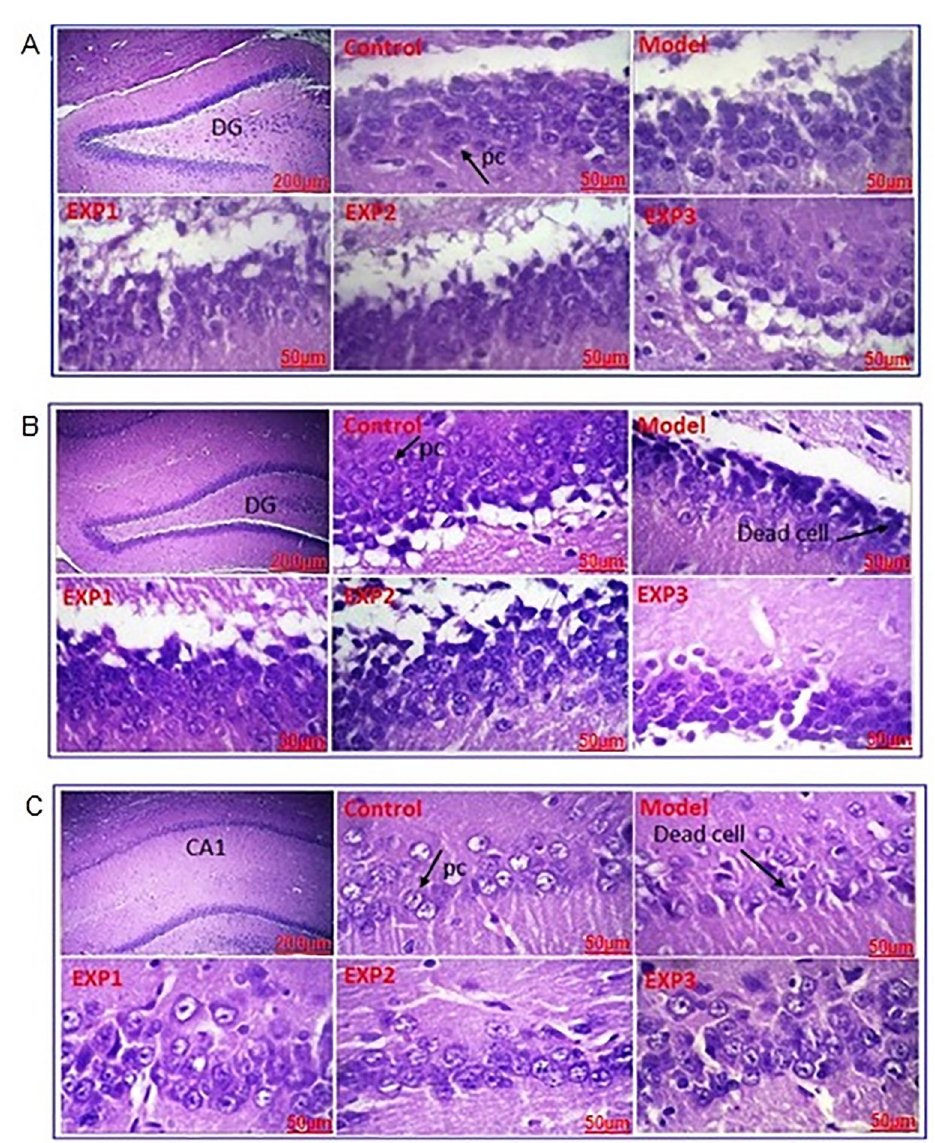
Figure 8. Light microscopic results of hippocampus (dentate gyrus (DG) and cornu ammonis (CA1)) samples stained by hematoxylin and eosin. First image in each box is at (cid:1) 40 magni fi cation (scale bar 200 m m) and the other images are at (cid:1) 400 magni fi cation (scale bar 50 m m). Please refer to the Table 1 for group de fi nitions. PC: pyramidal cells. A , Insulin amyloid effects in the presence and absence of trans -chalcone in the dentate gyrus region, ( B ) presence and absence of silibinin in the dentate gyrus region, and ( C ) presence and absence of silibinin in the CA1